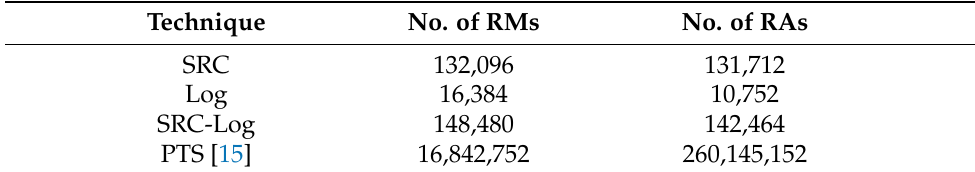
Table 2. Computational complexity comparison of SRC, Log, SRC-Log and PTS [15], based on (17) and